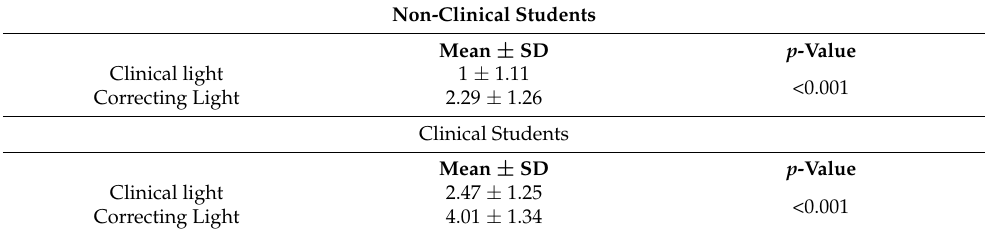
Table 4. Comparison of shade matching scores under clinical and correcting